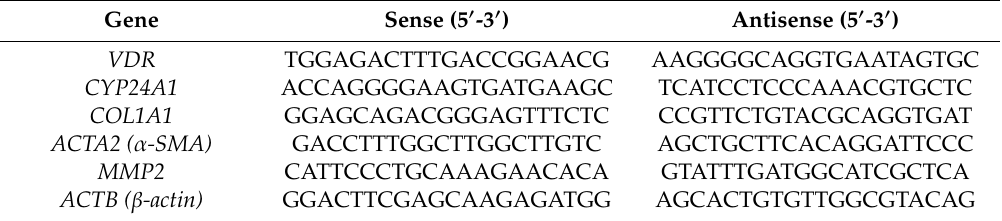
Table 2. Sequences of human primers used in real-time PCR.